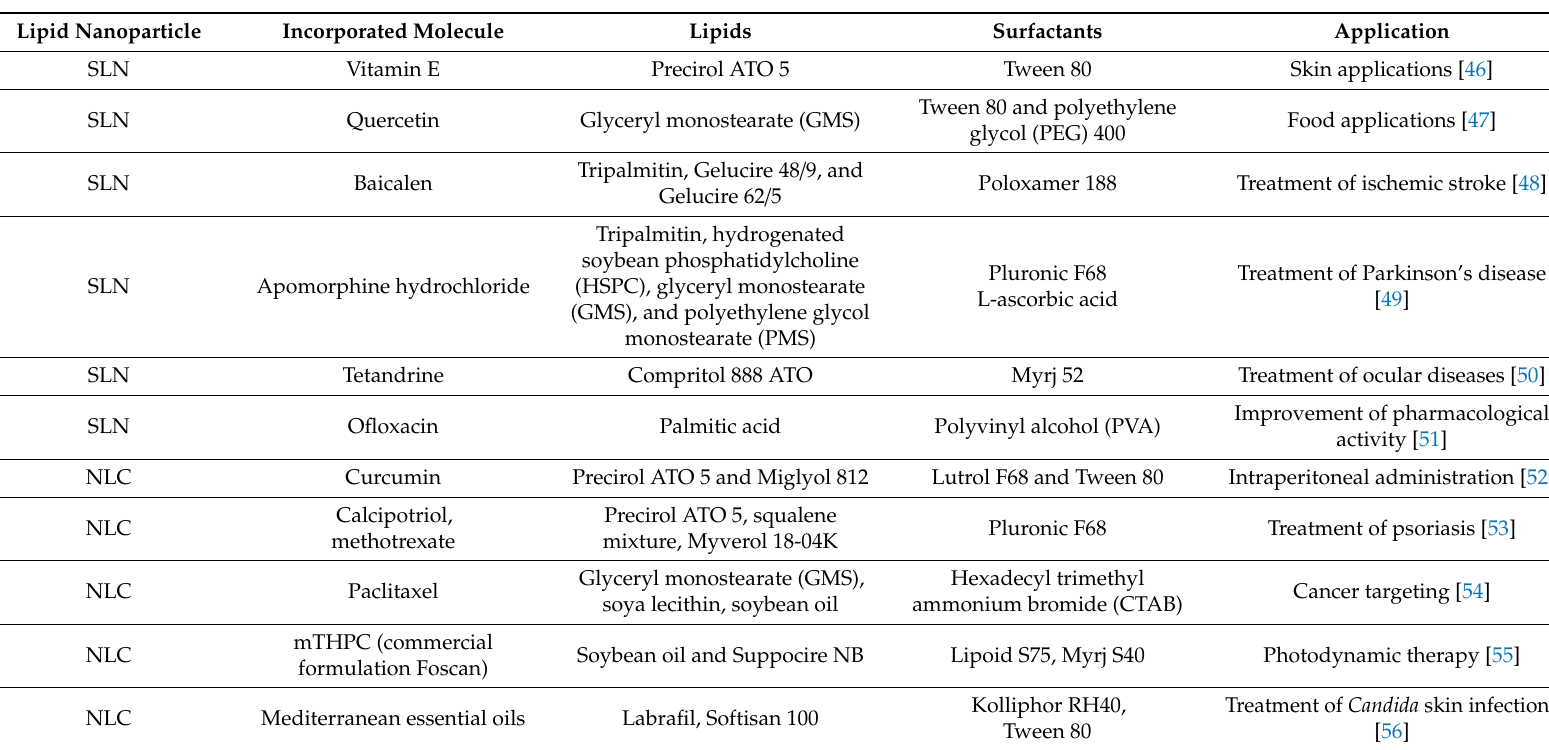
Table 2. Examples of solid lipid nanoparticle (SLN) and nanostructured lipid carrier (NLC) applications, lipids, and surfactants used in their